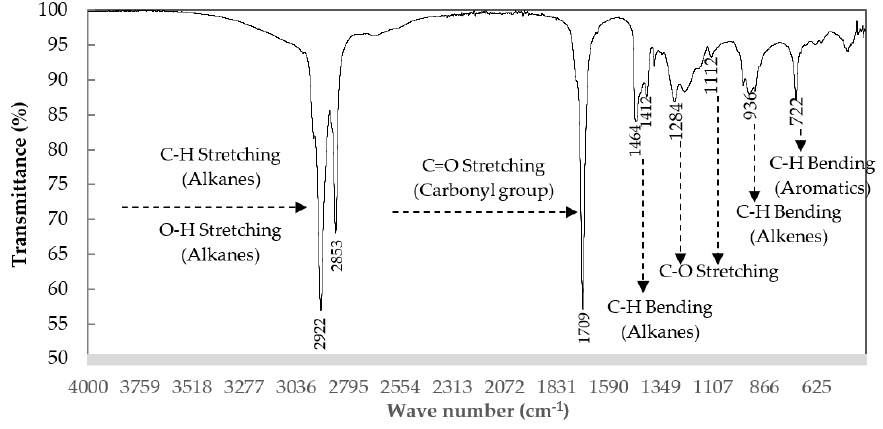
Figure 2. The FT–IR profile of the WCO used in this study. The physical and chemical properties of AC were characterized and shown in Table 3. The ultimate analysis data confirm that carbon is the dominant element of 72.33 wt.%. A BET surface area of 720.0 m 2 /g and average pore size of 0.95 nm were obtained from the adsorption/desorption of N 2 . The SEM images of AC morphology are shown in Figure 3. The morphology of AC is a granular shape with a high porous structure. Table 3. The characteristics of activated carbon. Properties Ultimate analysis